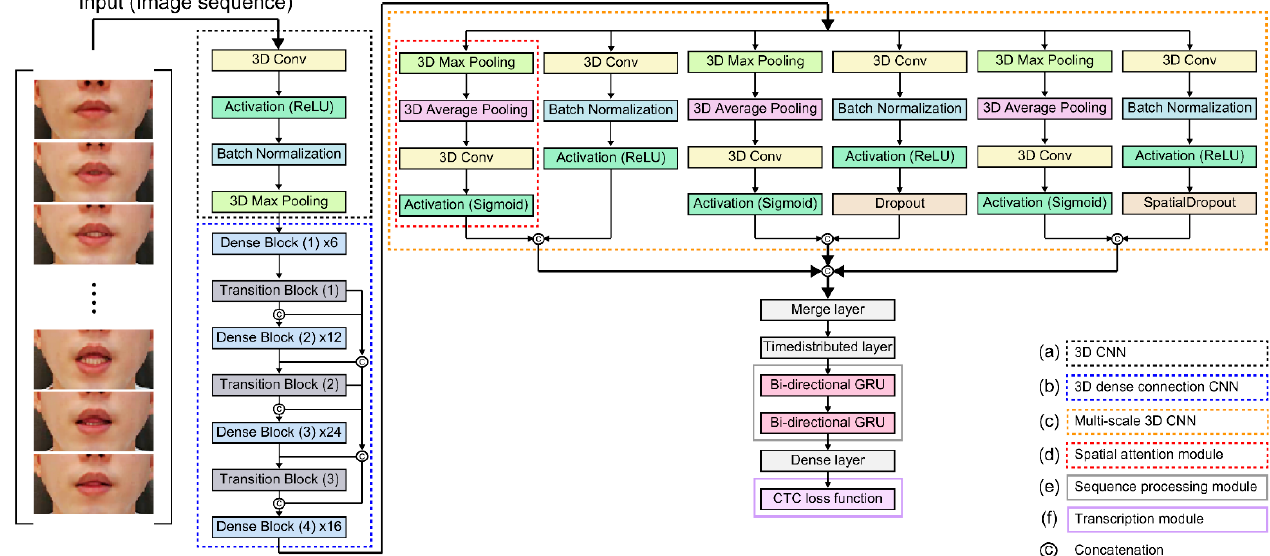
Figure 3. Detailed schematic of the proposed visual speech recognition module.